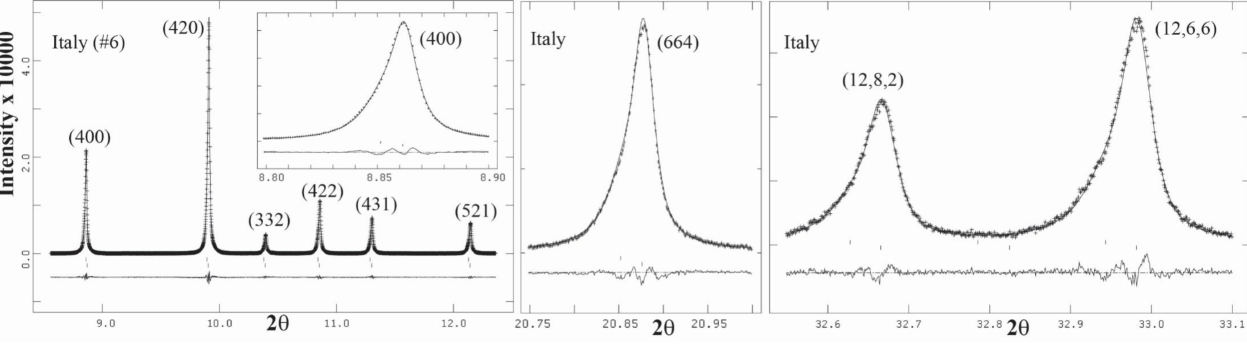
Figure 18. Expanded scale for sample-6 from Italy. Each reflection peak is clearly asymmetric because of two different cubic phases in the sample. There is a small hump on the left side off each reflection, especially the 12,6,6